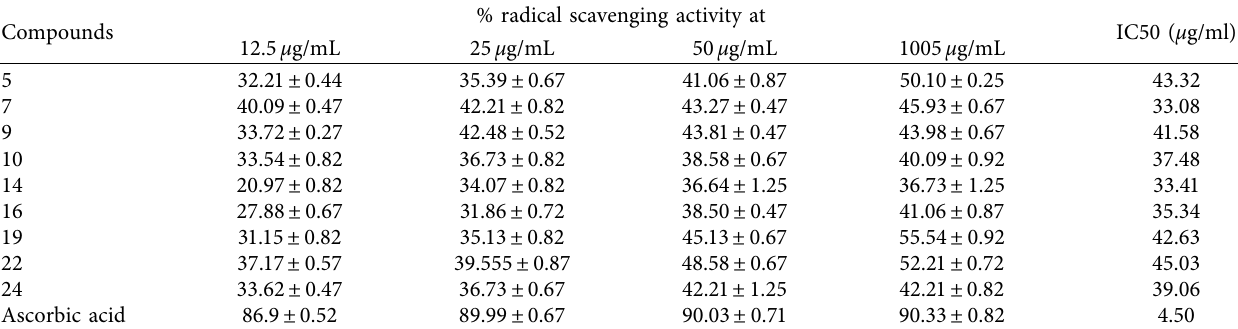
The antioxidant activity of the synthetic compounds was also elaborated in Figure 4 with a line diagram. Table 10: The Z -factor of radical scavenging activity of synthetic compounds and ascorbic acid.